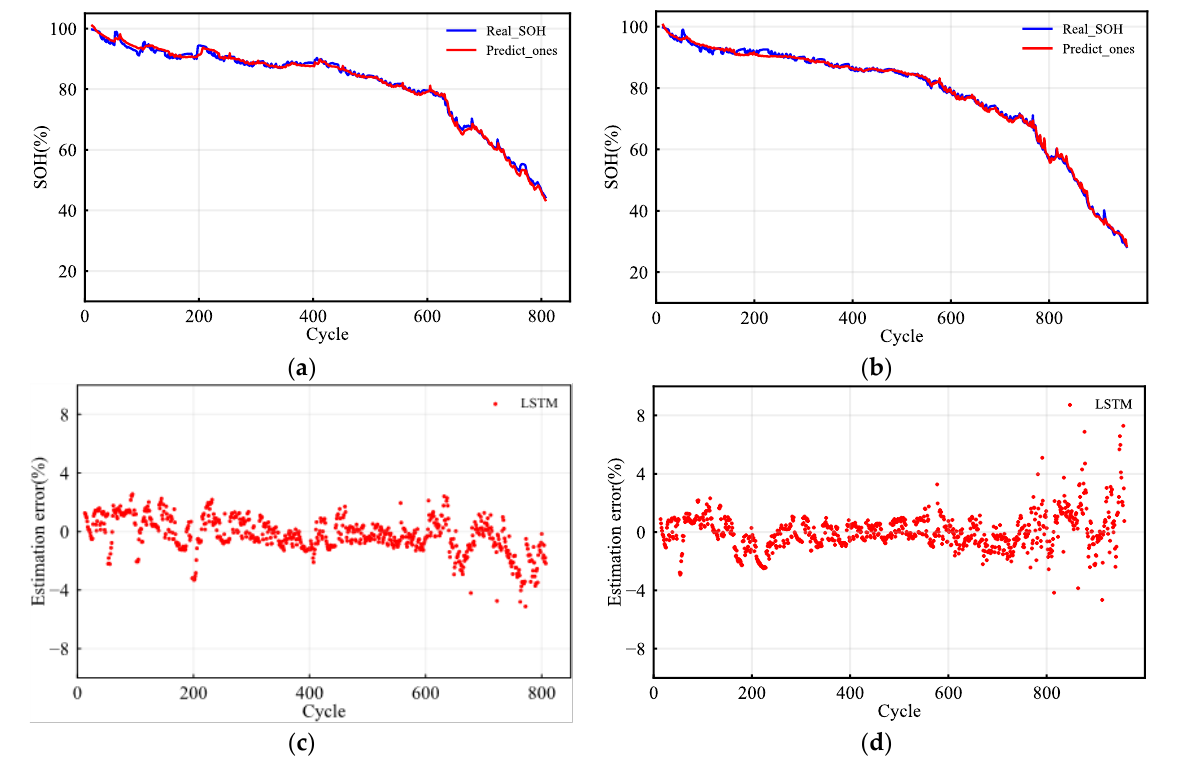
Table 3. The RMSE and MAE results for the batteries under different charging rates.